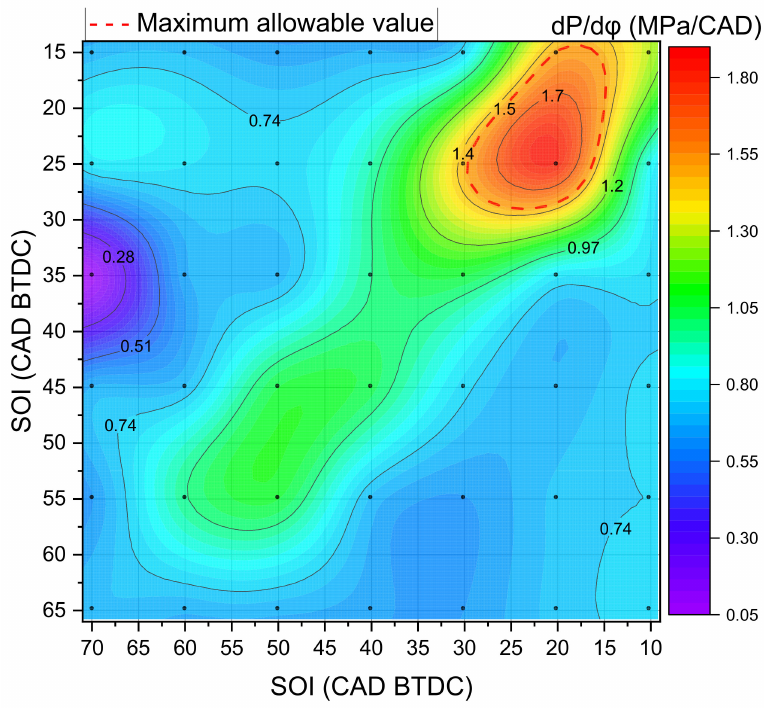
Figure 10. Pressure rise rate contour plot.